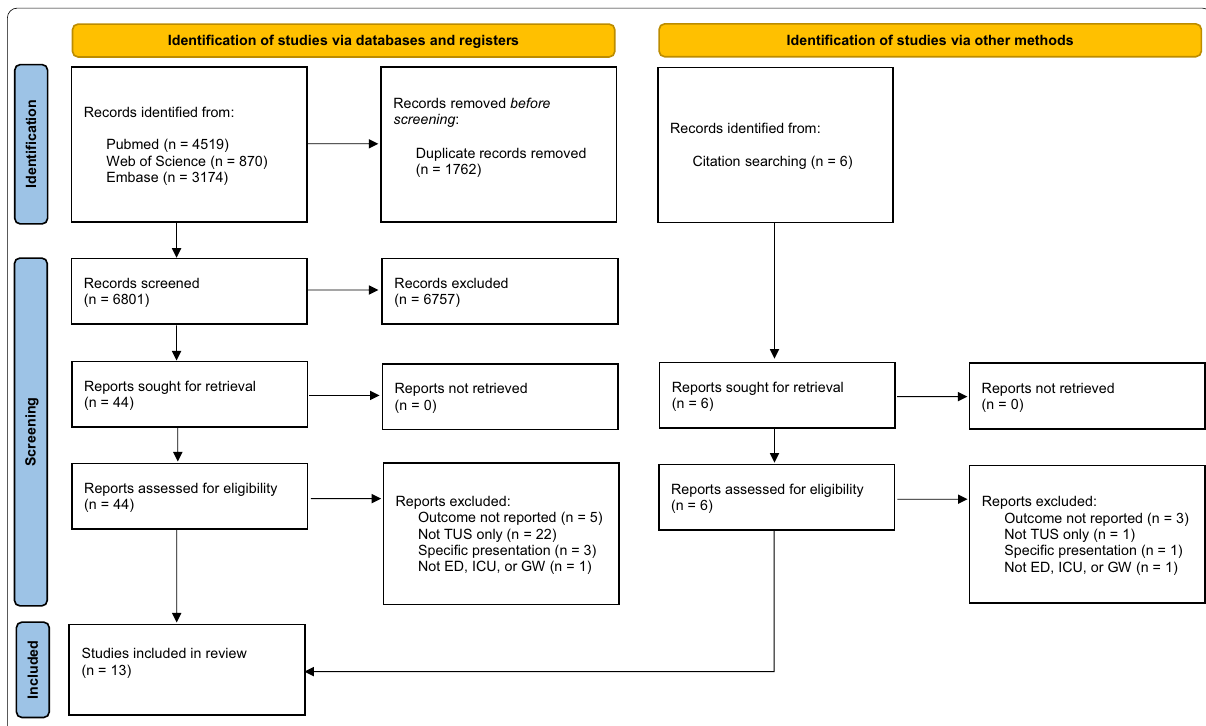
Fig. 1 PRISMA flow diagram. TUS thoracic ultrasound; ED emergency department; ICU intensive care unit; GW general